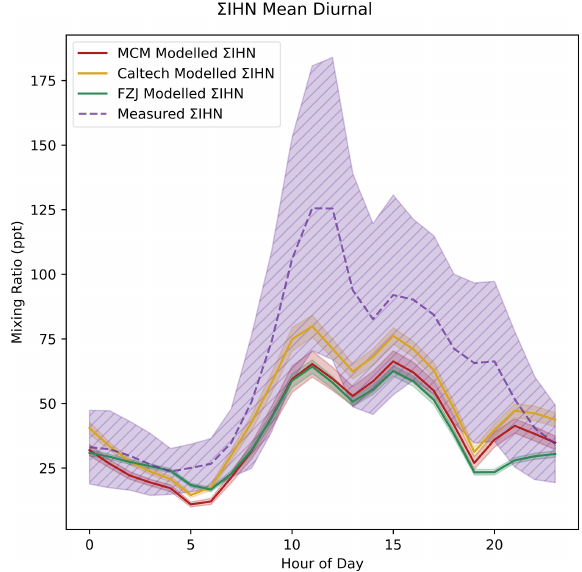
Figure 7. Measured and modelled (cid:54) IHN. Each line shows the mean value for each dataset, with the shaded area indicating 1 stan- dard deviation above and below the